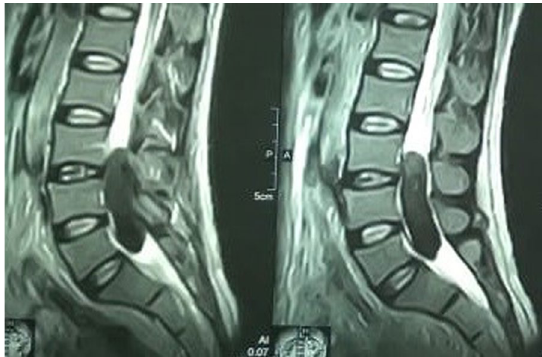
Fig. 2 Well-circumscribed intradural mass at the L3–S1 level hypointense on T2